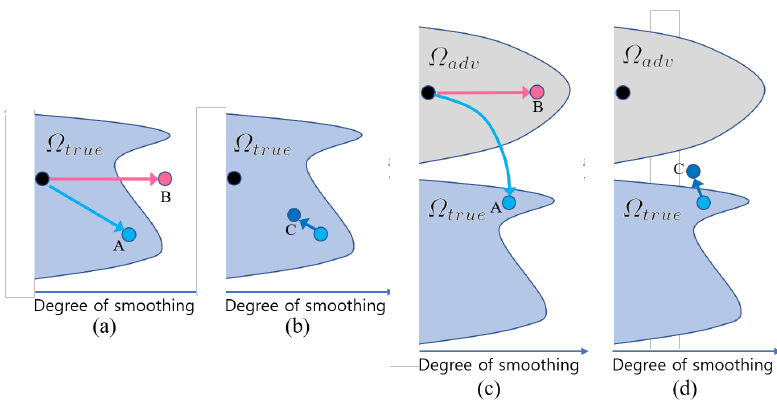
Figure 5. Explanation of the parameter domain. ( a ) effect of putting a normal image through the blurring network ( b ) effect of putting a normal image through the DIP ( c ) effect of putting an adversarial image through the blurring network ( d ) effect of putting an adversarial image through the